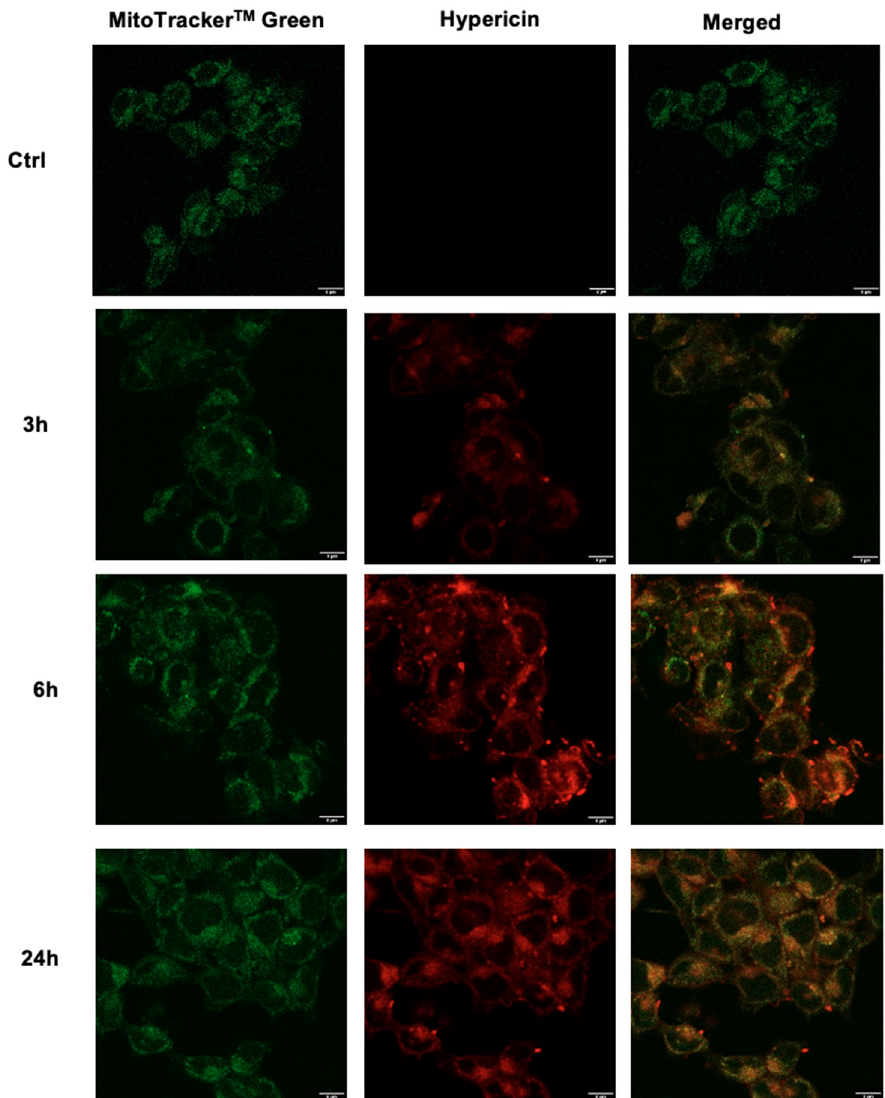
Figure 3. Confocal fluorescence images of HT-29 cells incubated with Hyp 0.1 µ M for 3, 6, and 24 h. Pictures in green indicate MitoTrackerTM green used as a mitochondrial counterstain. Pictures in red indicate Hyp. On the right of the panel, merged images indicate the overlay between MitoTracker TM green and Hyp. Magnification: 40 × , scale bar: 8 µ m.